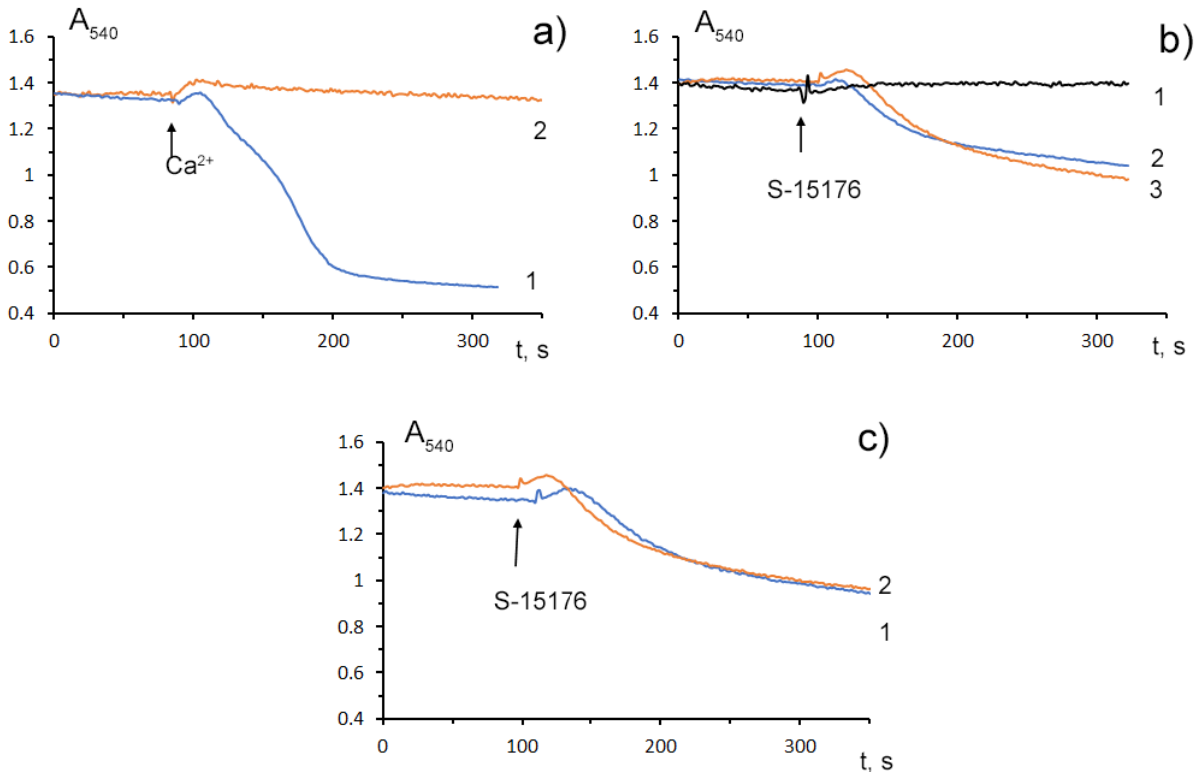
Figure 4. Swelling assay of rat liver mitochondria (0.35 mg/mL) treated with S-15176 difumarate salt; ( a ) Preincubation of mitochondria with 10 µ M S-15176 for 1 min (2) blocks mitochondrial swelling induced by 50 µ M Ca 2+ in the presence of 1 mM P i (1); ( b ) S-15176 by itself induces mitochondrial swelling when its concentration is increased from 10 µ M (1) to 30 µ M (2) or 50 µ M (3); ( c ) Pretreatment of rat liver mitochondria with 1 µ M cyclosporin A (2) does not affect mitochondrial swelling induced by 30 µ M S-15176 (1). Typical traces are shown ( n = 5).